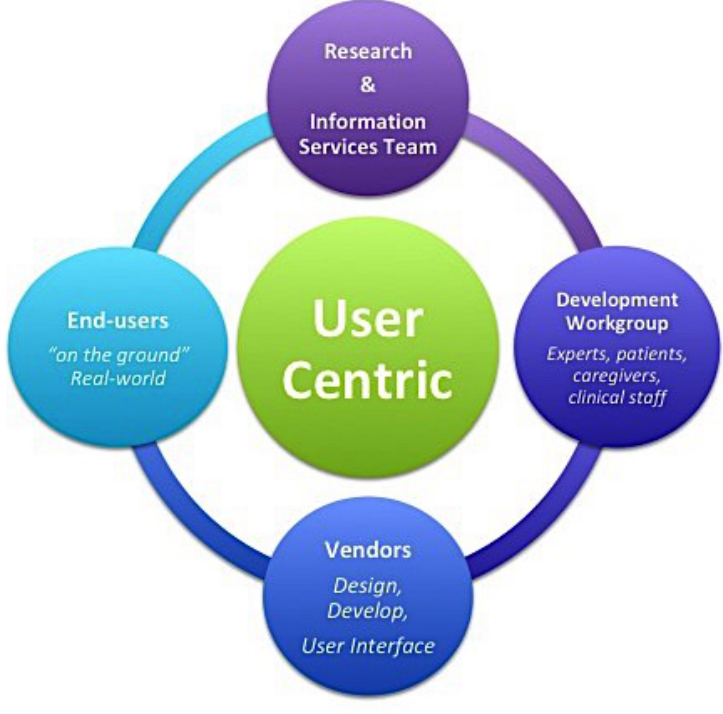
Figure 1. User-centric design process to engage the Development Workgroup and real-world end-users.